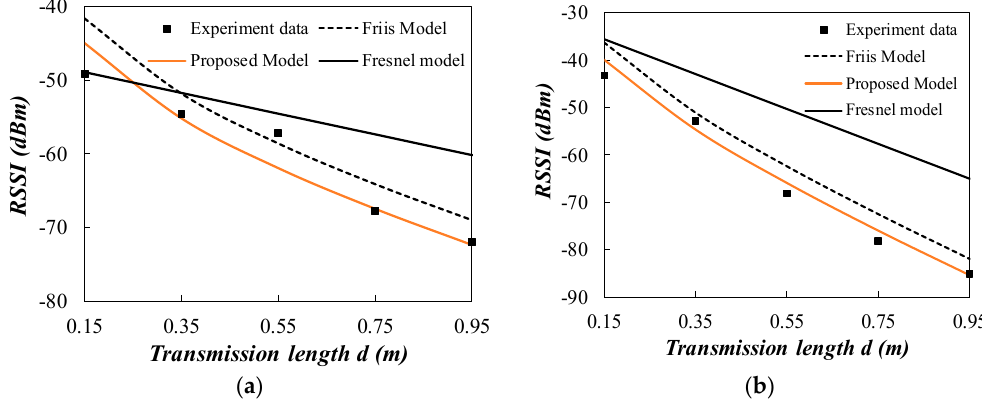
Figure 12. Comparison of the measured experiment data from the literature [32] with the propagation models. ( a ) σ = 37.61 mS/m, ε r = 19 for 8% wet sand ( b ) σ = 123.61 mS/m, ε r = 30 for 15% wet sand. Table 5. R 2 and RMSE of the propagation models fitting the experiment data from the literatures.